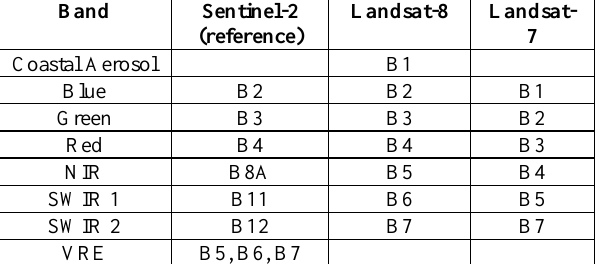
Table 1. Band matching among Sentinel-2, Landsat-8 and Landsat-7 images for radiometric calibration